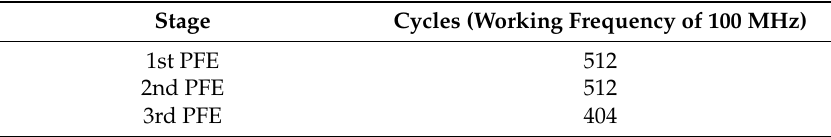
Table 2. Time consumption of three PFE procedures.